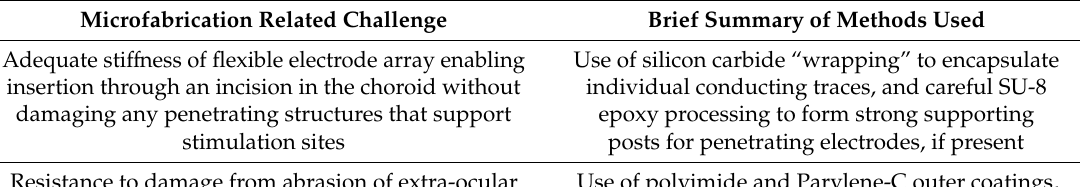
Table 1. Some common micro-fabrication challenges unique to retinal prosthetics, and methods used by the Bionic Eye team to address these